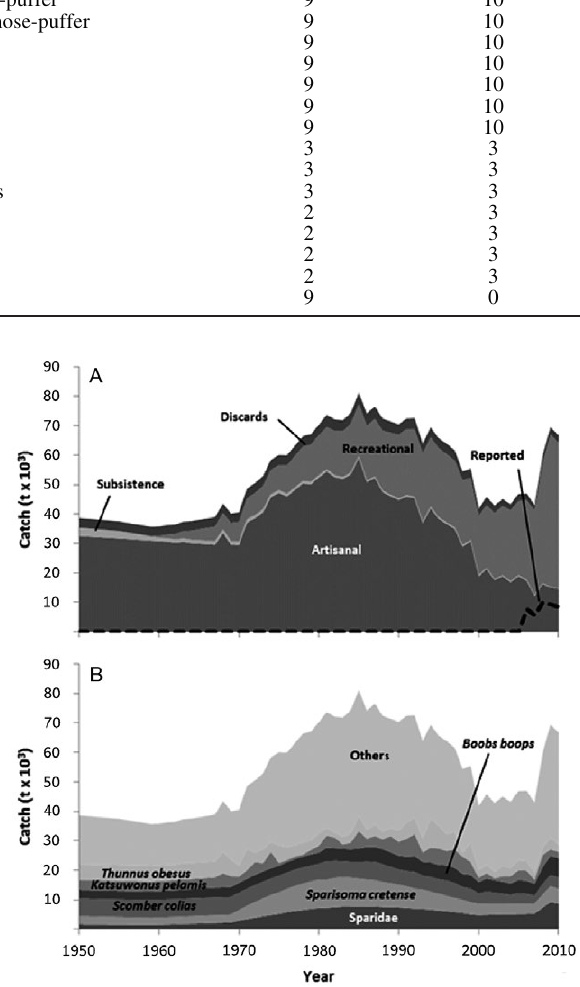
Fig. 9. – Reconstructed total catch for the Canary Islands (1950- 2010), by sector (A), with official reported data overlaid as line graph; and major taxa (B), with “Others” consisting of over 90 ad- ditional taxa (see Appendix